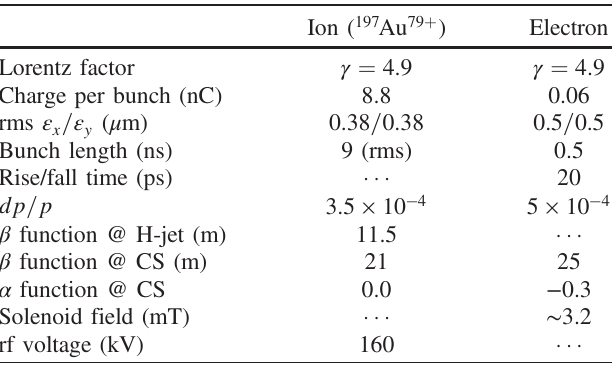
TABLE II. Beam parameters for the heating study.